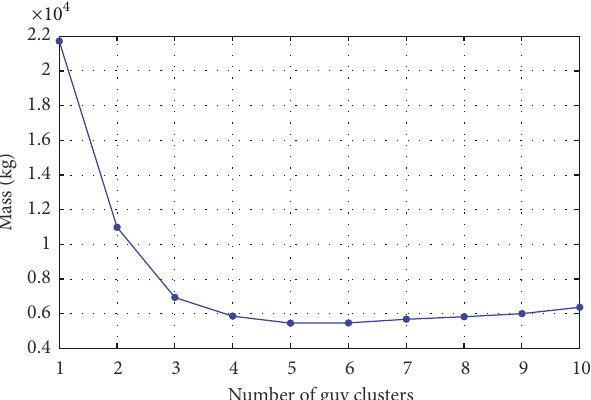
Figure 5: Dependence of the mast mass on the number of guys’